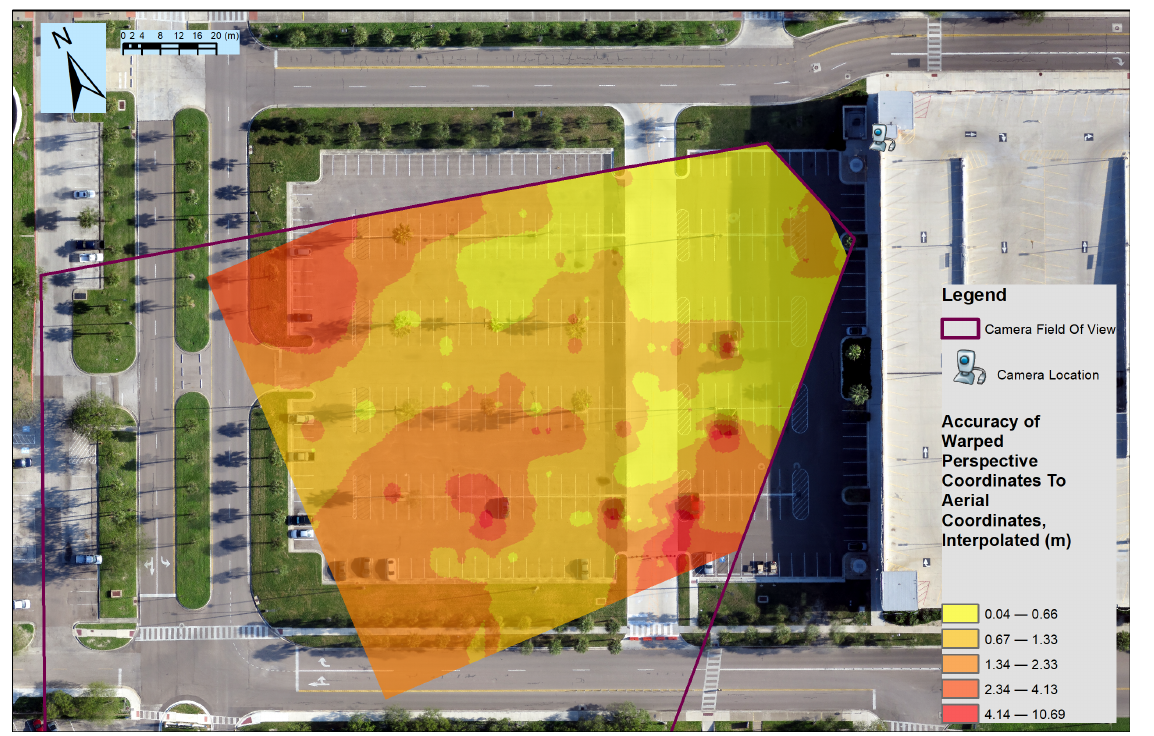
Figure 9. Transformation accuracy from each perspective pixel to coordinates on the aerial image, interpolated by inverse distance weighting.